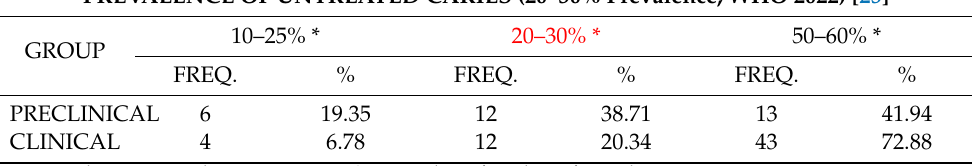
Table 6. Differences between groups in the prevalence of untreated caries ( p = 0.012) (correct answer red